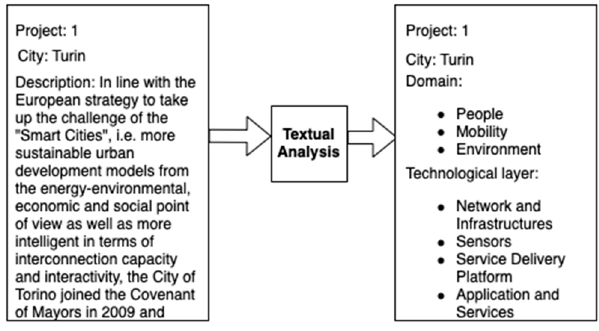
Figure 10. Textual analysis.